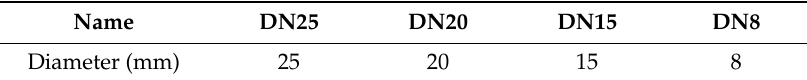
Table 2. Leak hole diameter.